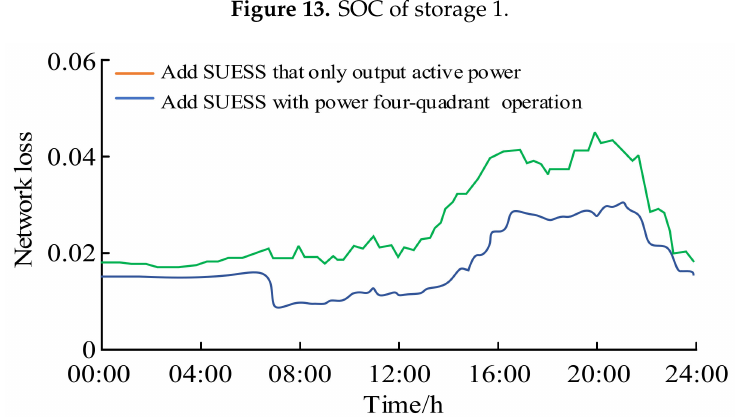
Figure 14. Two cases of the distribution network loss.